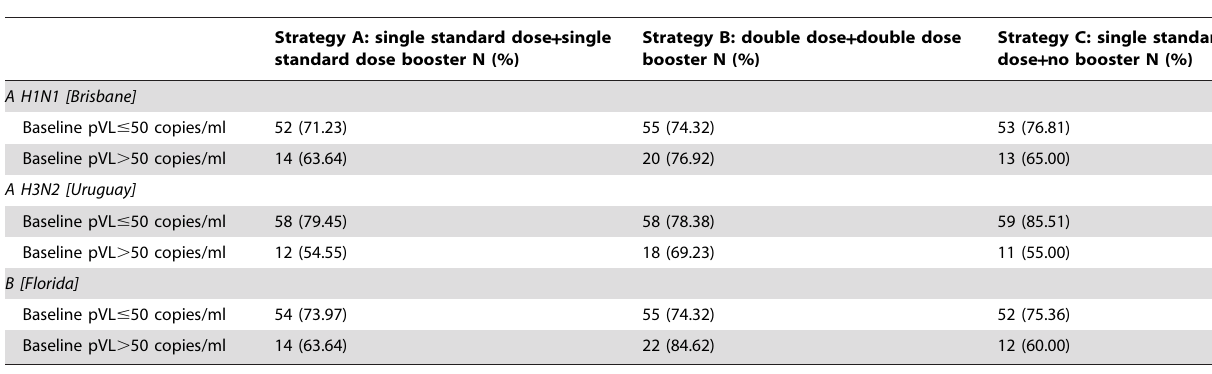
Table 3. Probability of HAI titre improvement*: results from 1 st -stage